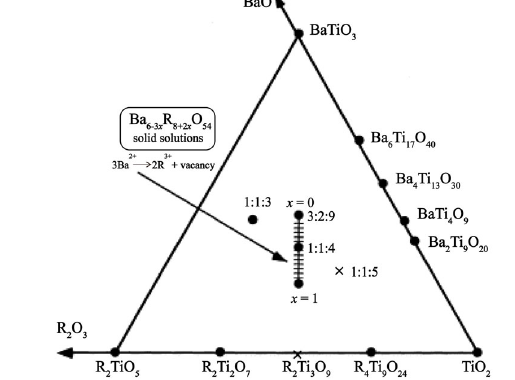
Fig. 16 BaO–R 2 O 3 –TiO 2 (R = rare earth) ternary system. Reproduced with permission from Ref. [310], © Elsevier Science Ltd.